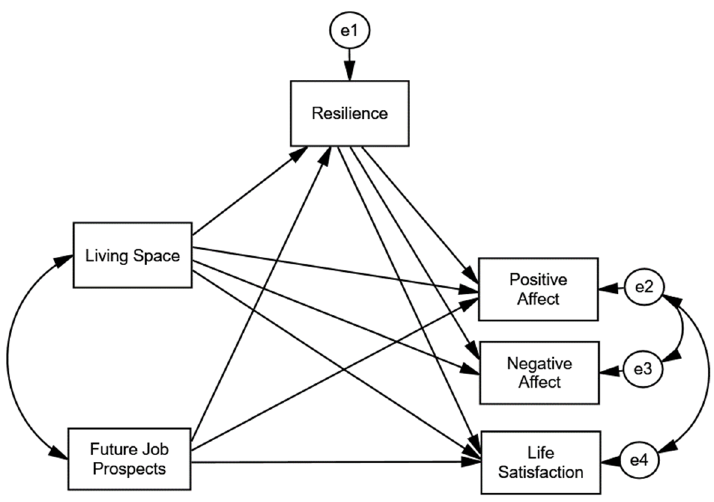
Figure 1. Hypothesised